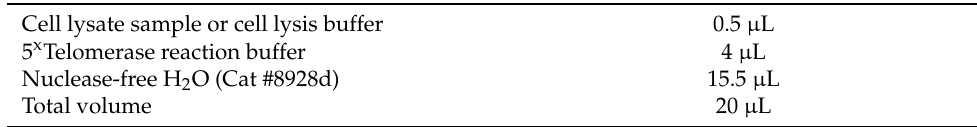
Table 5. Items used for the telomerase reactions.